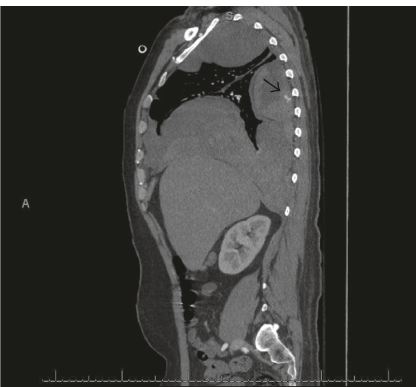
Figure 2: Arterial phase of CT chest scan in sagittal plane shows blushes of contrast (arrow) extending into the hematoma at the level of 7th posterior rib.